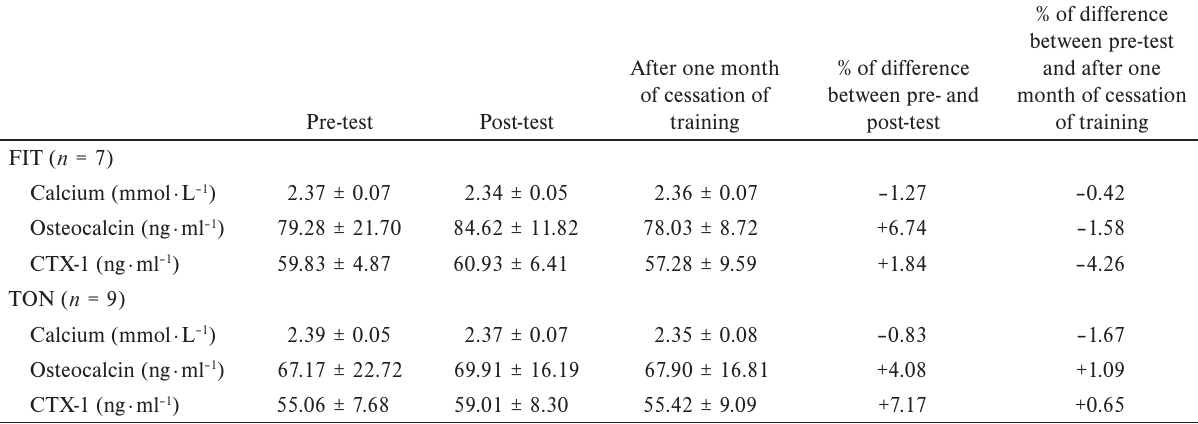
Serum total calcium, osteocalcin and C-telopeptide of type 1 collagen (CTX-1) before (pre-test), after eight weeks of training (post-test) and after one month of cessation of training in isokinetic (FIT) and isotonic (TON) groups. Values are presented as M ±